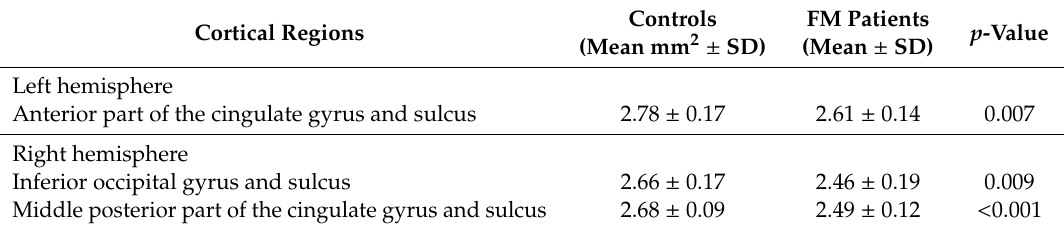
Figure 4. Cortical Thickness di ff erences in cingulate gyrus subparts between fibromyalgia (FM) patients (red boxes) and healthy controls (blue boxes). On each box, the horizontal line is the median and the edges of the box are the 25th and 75th percentiles. The p -value was determined by the two-tailed t -test for independent samples. ( a ) Left anterior cingulate gyrus; ( b ) middle posterior part of the right cingulate gyrus. Table 3. The mean and standard deviation (sd) of the variables for cortical thickness, separately for controls and FM patients. Significant p -value were considered for p ≤ 0.01.